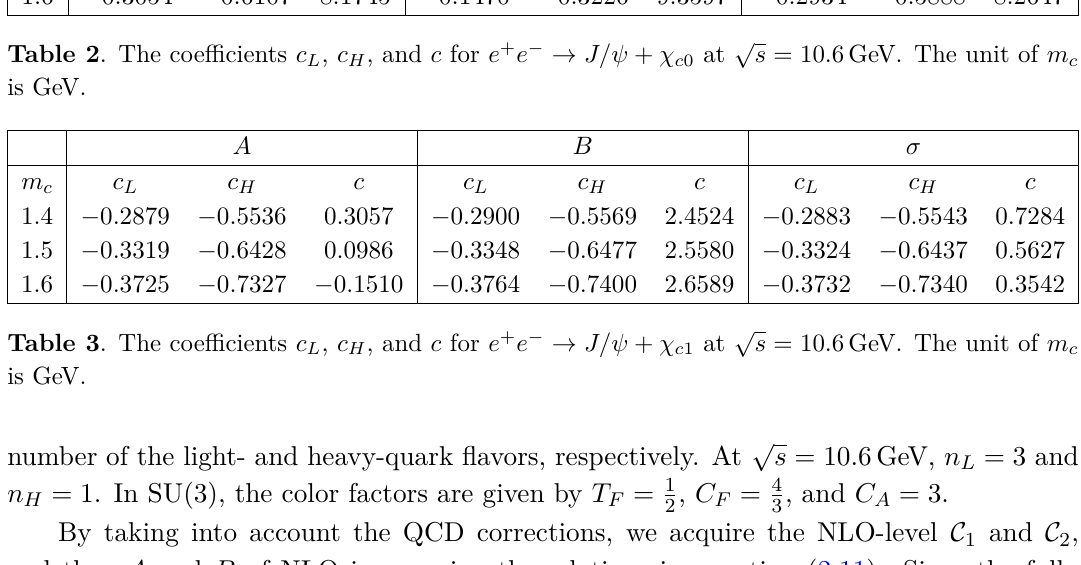
√ s = 10 . 6 GeV. The unit of m c